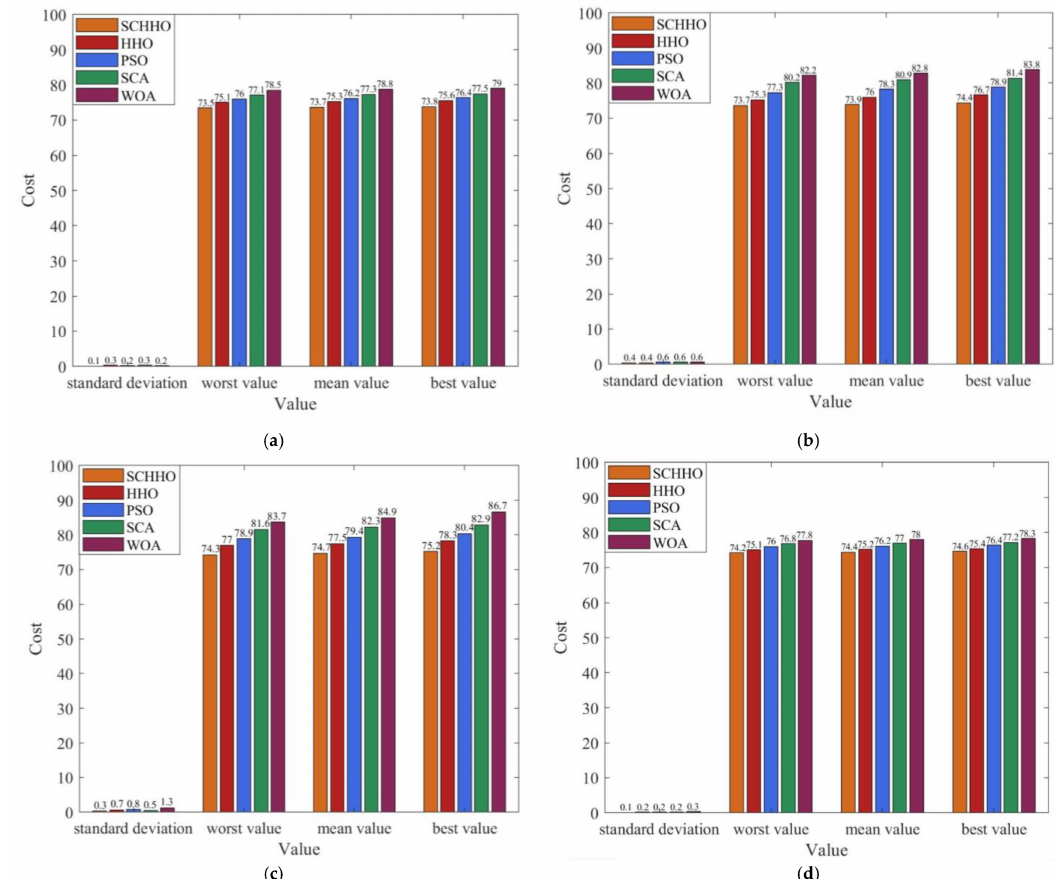
Figure 7. Statistical results of cost function values. ( a ) Case 1. ( b ) Case 2. ( c ) Case 3. ( d ) Case 4.